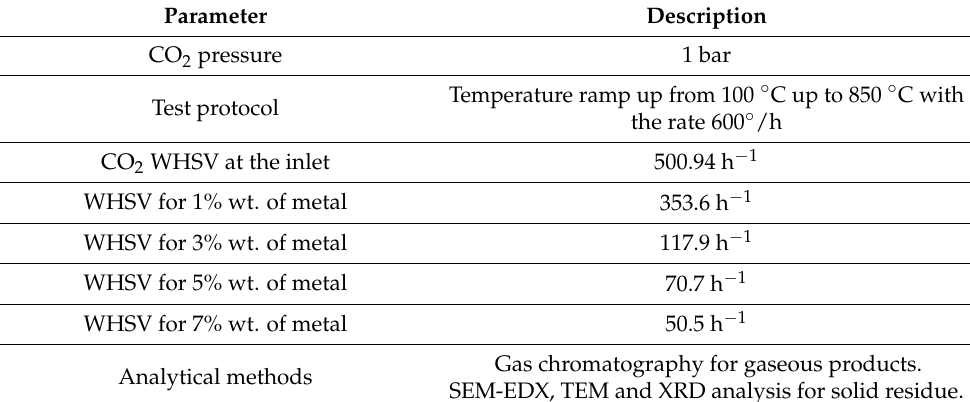
Table 1. The main parameters of the gasification process.